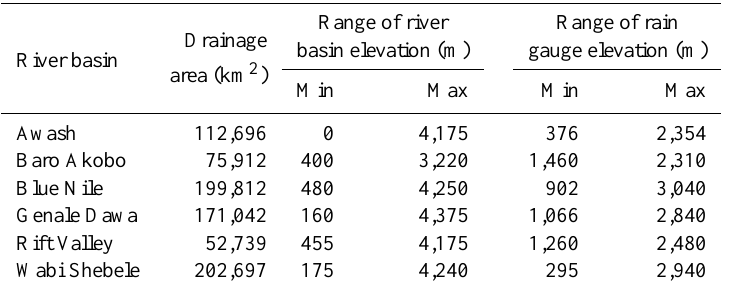
Table 2. River basin drainage area and topography.